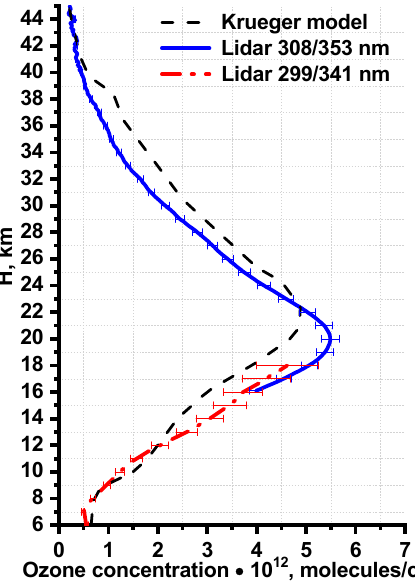
Figure 3. Average profile retrieved in the upper troposphere–stratosphere in 2018.